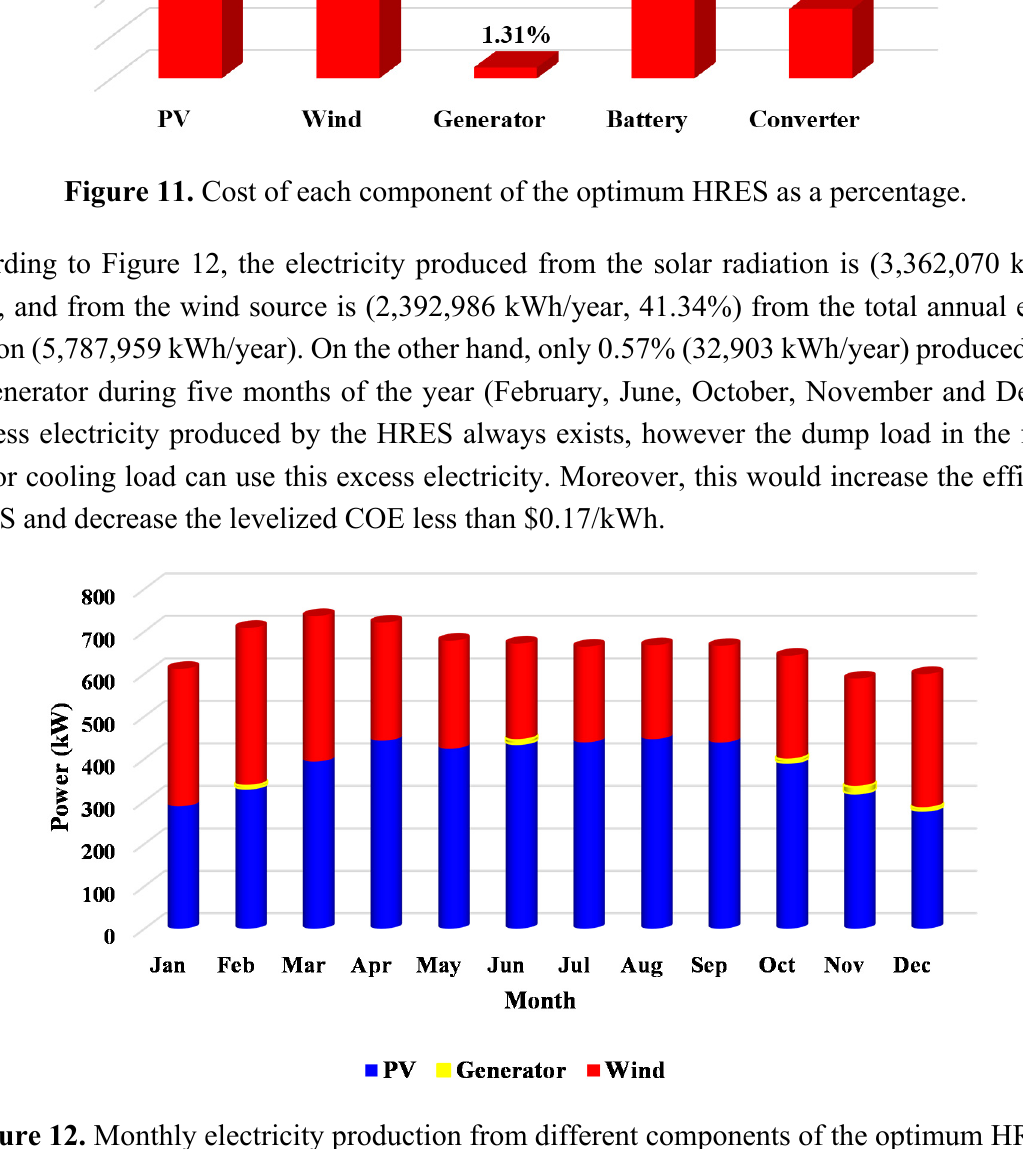
Figure 12. Monthly electricity production from different components of the optimum